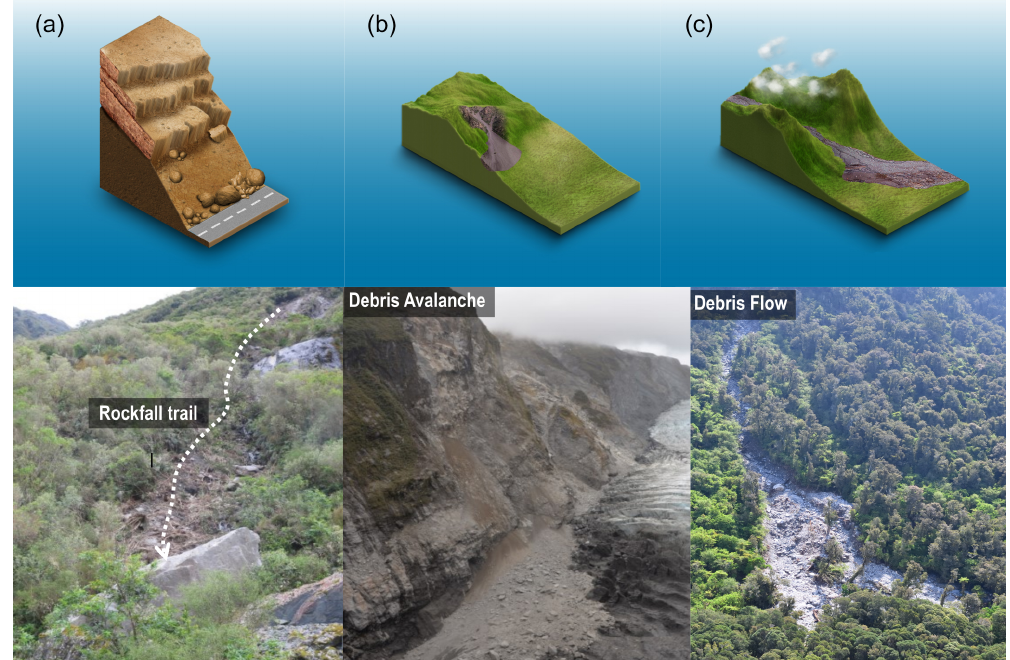
Figure 2. Schematic and example photographs of landslide types considered in the QRA, including (a) rockfall, (b) debris and rock avalanches, and (c) debris